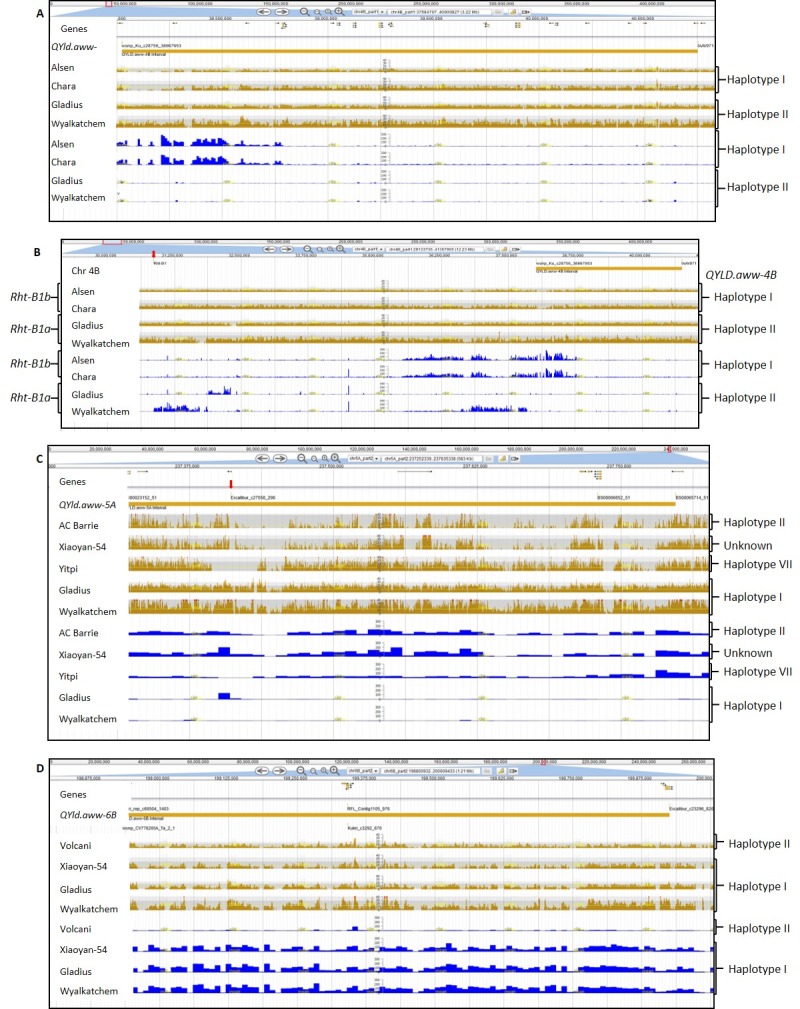
DAWN screenshot of the three yield QTL regions aligned to Chinese Spring reference sequence, RefSeq v1.0.The “Genes” track shows the high confidence genes according to the RefSeq annotation v 1.0. The yellow tracks show the number of reads from a wheat accession that aligns to RefSeq v1.0 at each position of the genome. The blue tracks show the variant density (SNP per 10 Kb–log scaled) between reads from a wheat accession and RefSeq v1.0. (A) The “QYld.aww-4B” track shows the QTL interval and the position of the significantly associated markers. (B)–The “Chr4B” track shows the region on chromosome 4B containing QYld.aww-4B and Rht-B1. Different patterns across the blue tracks in the QYld.aww-4B and Rht-B1 regions indicate that these two regions segregate independently. (C)–The “QYld.aww-5A” track shows the QTL interval and significantly associated markers. The red arrow indicates the region of the marker Excalibur_c27558_298. (D)–The “QYld.aww-6B” track shows the QTL interval and the significantly associated markers.